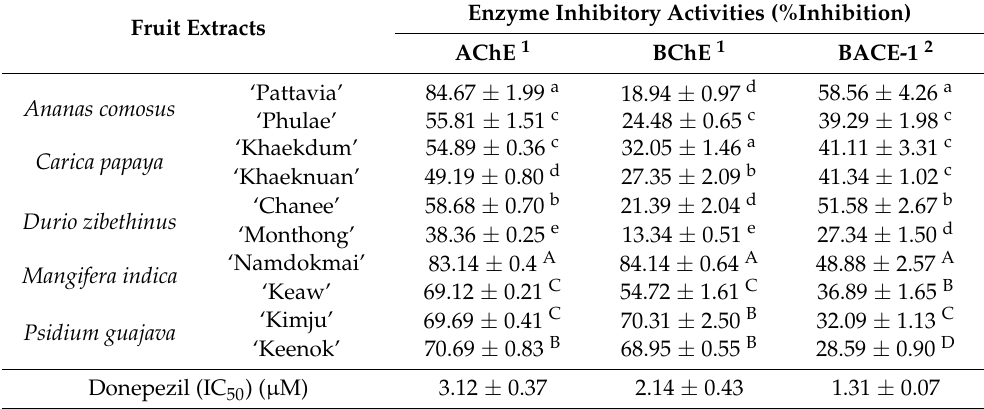
Table 1. Inhibitory activities on the key enzymes related to Alzheimer’s disease (AD) of ten fruit extracts in comparison to an AD drug, donepezil. Enzyme Inhibitory Activities (%Inhibition) Fruit Extracts AChE 1 BChE 1 BACE-1 2 ‘Pattavia’ 84.67 ± 1.99 a 18.94 ± 0.97 d 58.56 ± 4.26 a Ananas comosus ‘Phulae’ 55.81 ± 1.51 c 24.48 ± 0.65 c 39.29 ± 1.98 c ‘Khaekdum’ 54.89 ± 0.36 c 32.05 ± 1.46 a 41.11 ± 3.31 c Carica papaya ‘Khaeknuan’ 49.19 ± 0.80 d 27.35 ± 2.09 b 41.34 ± 1.02 c ‘Chanee’ 58.68 ± 0.70 b 21.39 ± 2.04 d 51.58 ± 2.67 b Durio zibethinus ‘Monthong’ 38.36 ± 0.25 e 13.34 ± 0.51 e 27.34 ± 1.50 d ‘Namdokmai’ 83.14 ± 0.4 A 84.14 ± 0.64 A 48.88 ± 2.57 A Mangifera indica ‘Keaw’ 69.12 ± 0.21 C 54.72 ± 1.61 C 36.89 ± 1.65 B ‘Kimju’ 69.69 ± 0.41 C 70.31 ± 2.50 B 32.09 ± 1.13 C Psidium guajava ‘Keenok’ 70.69 ± 0.83 B 68.95 ± 0.55 B 28.59 ± 0.90 D Donepezil (IC 50 ) ( µ M) 3.12 ± 0.37 2.14 ± 0.43 1.31 ±